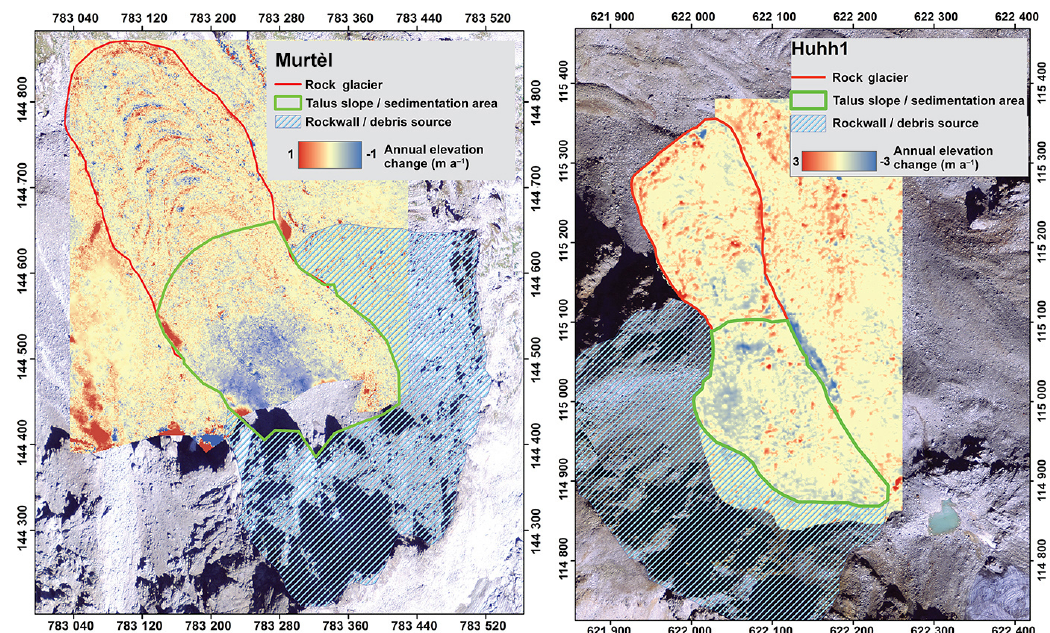
Figure 2. The annual elevation change of the two rock glacier systems for Murtèl (period 1996–2007) and Huhh1 (period 2001–2012). The annual rates are derived from multisensoral and multitemporal remote sensing products (Table 2). For a detailed depiction of the structure of the landforms see Supplement Fig. S1, where the orthophoto is shown without the elevation